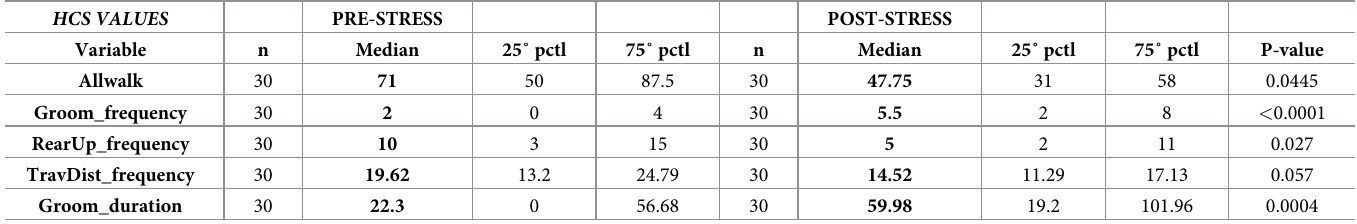
Table 4. HCS median values with interquartile ranges (25˚ ptcl-75˚ ptcl). Irrespectively to handling method, R&L stress caused a significant reduction in walking and rearing frequency, and an increase in grooming duration and frequency in all animals. HCS